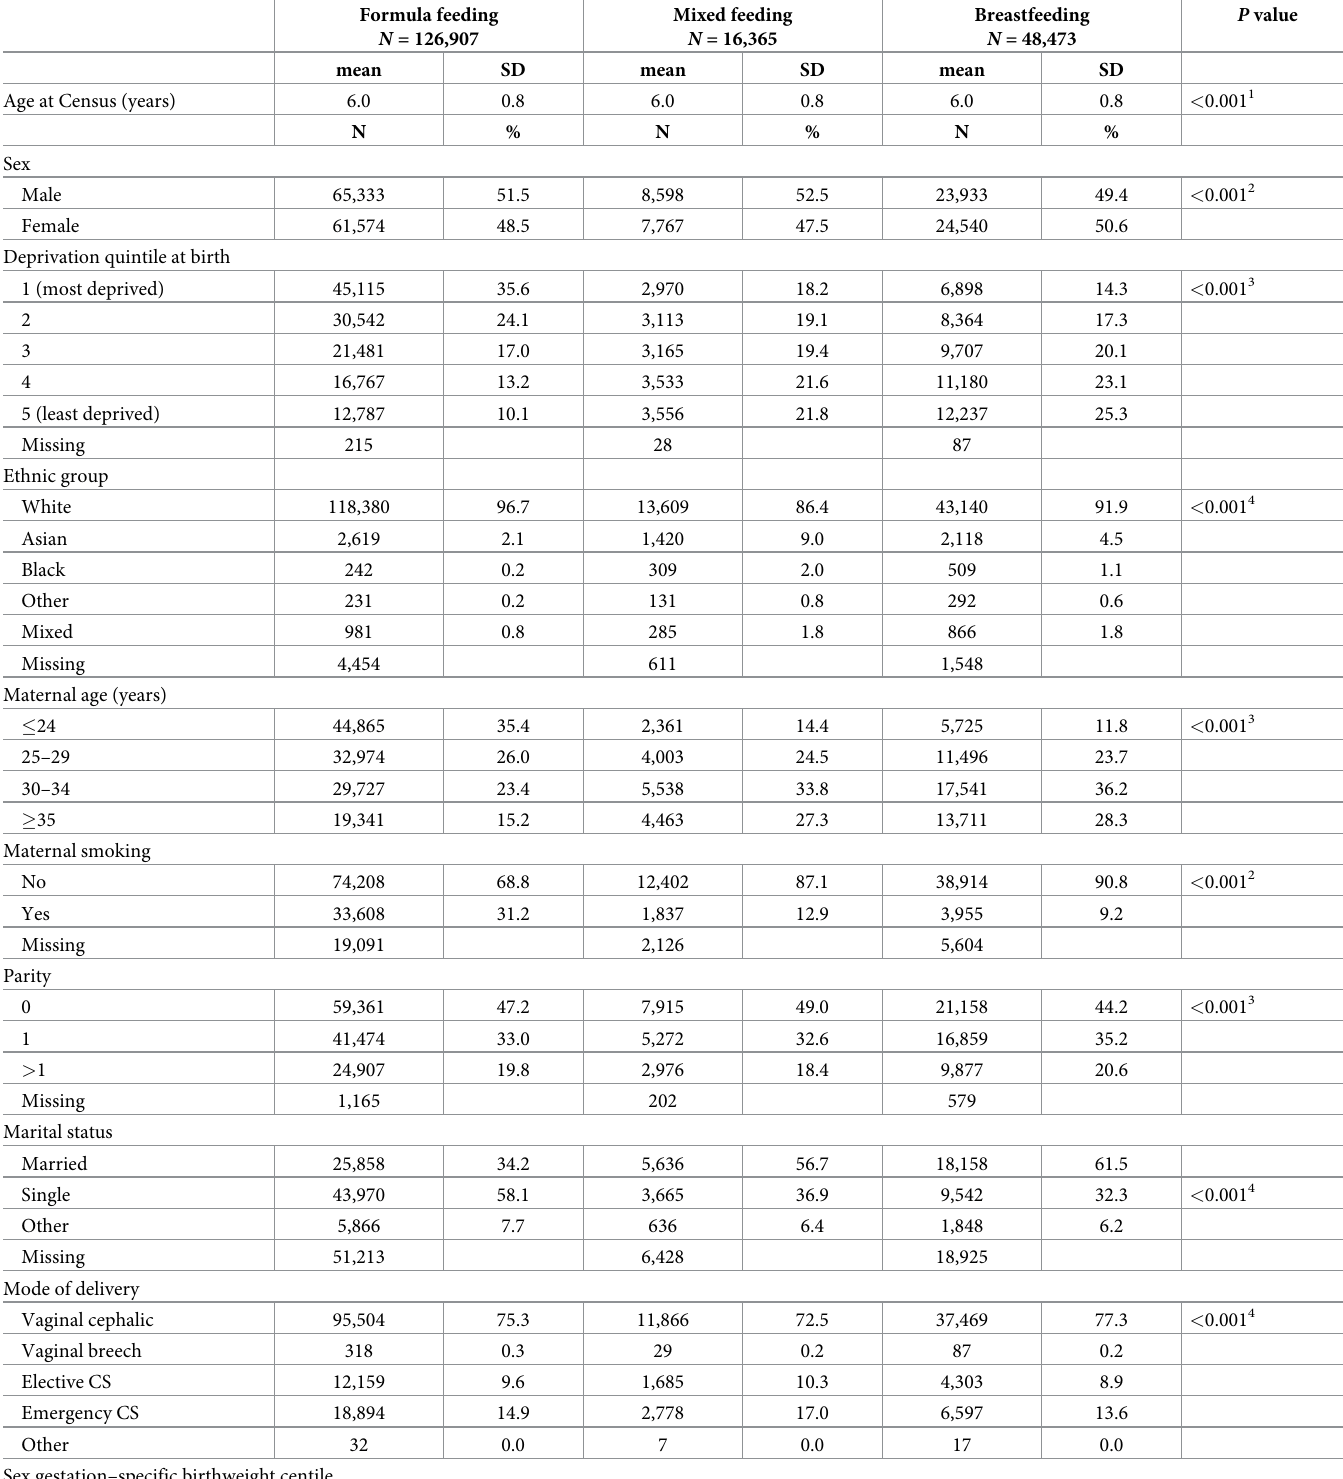
Table 1. Child, maternal, and pregnancy characteristics by feeding method at 6–8 weeks of age.